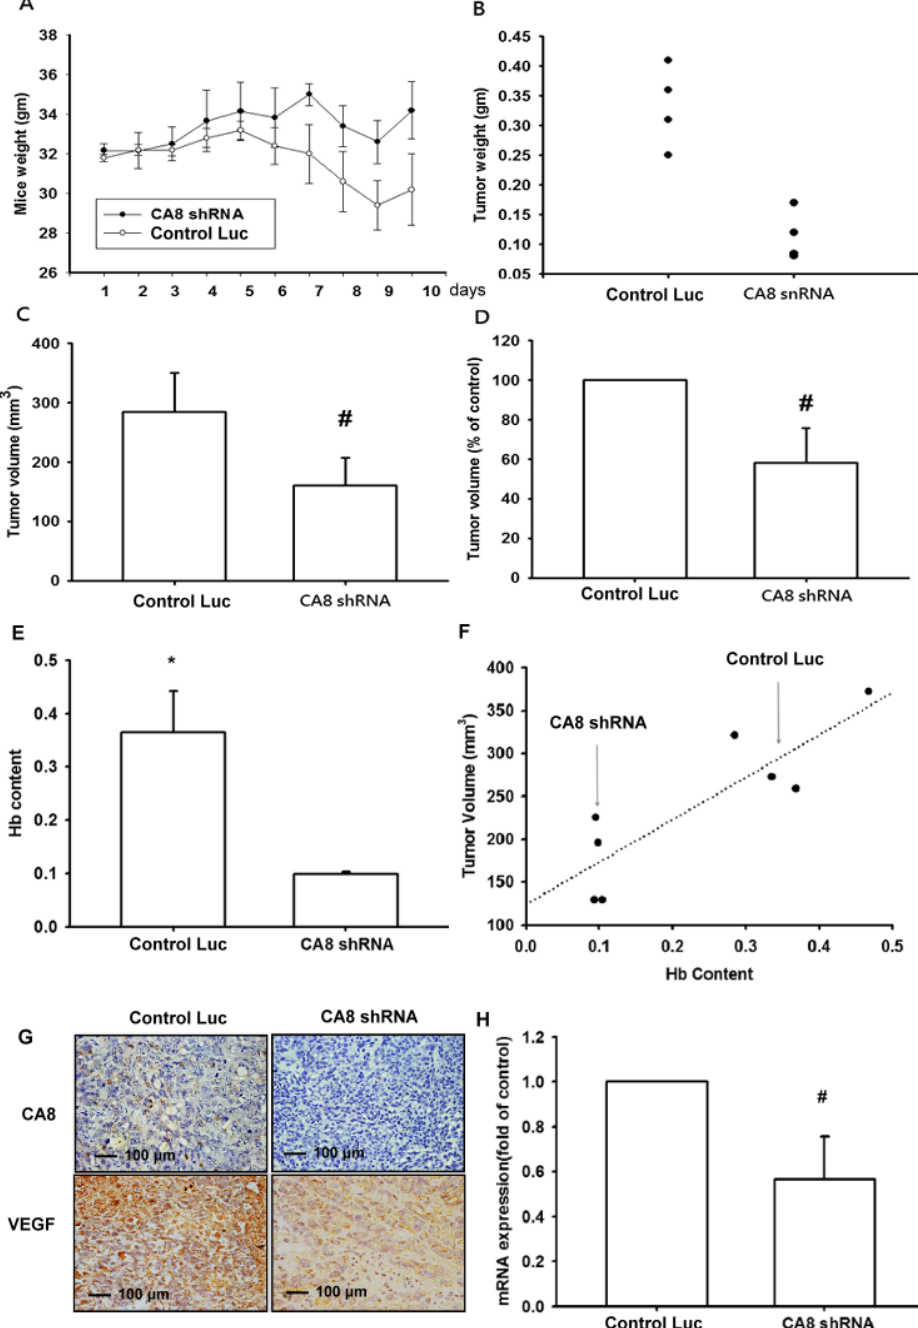
Figure 6. Knockdown of CAVIII decreases tumor-associated angiogenesis in mice. ( A – E ) SW480/control luc or Sw480/CA8 shRNA cells were mixed with Matrigel and injected into flank sites of mice for 10 days, and then resected. The tumors were photographed with a microscope, weight and volume were measured, and the hemoglobin levels were quantified. The correlation between tumor volume and hemoglobin levels is shown in ( F ). ( G , H ) The tumor was excised from